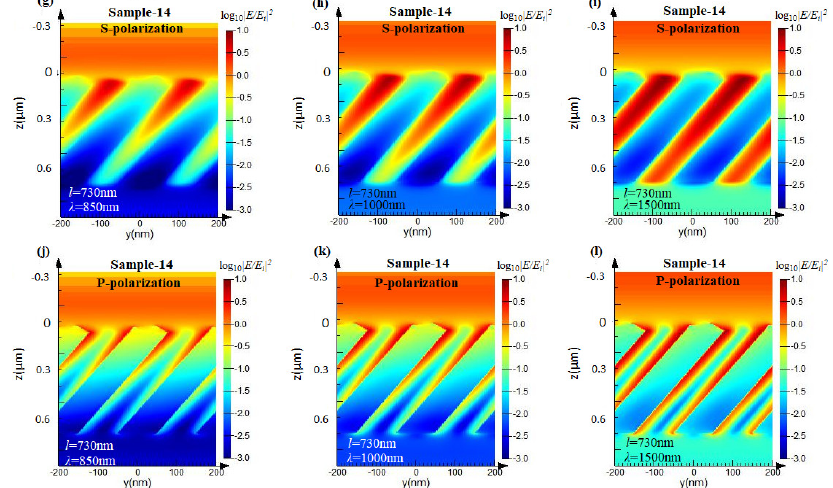
Figure 11. Simulated electric field intensities of ( a – f ) 456 nm long nanorods and ( g – l ) 730 nm long nanorods in cross-sections ( x = 0) at incident wavelengths of 850, 1000, and 1500 nm for s- and p-polarization.